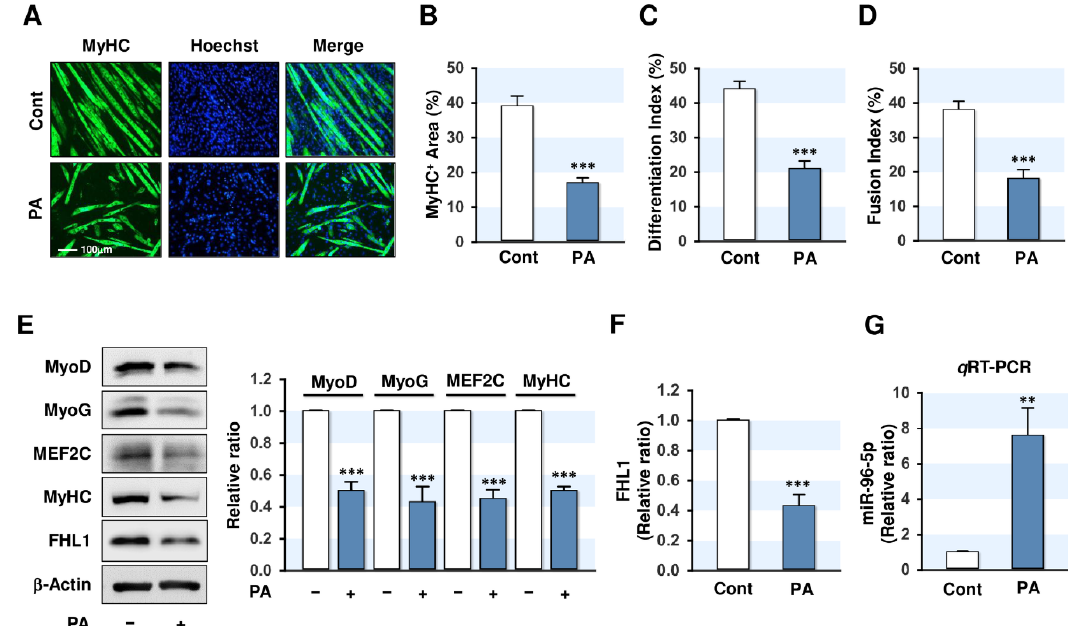
Figure 1. Palmitic acid (PA) impairs myogenic differentiation and upregulates miR ‐ 96 ‐ 5p in C2C12 myoblasts. C2C12 myoblasts were pretreated with PA (100 μ M) for 24 h and differentiated up to five days. ( A ) Immunofluorescence staining with a specific antibody against MyHC (green). Hoechst (blue) was used to stain nuclei. Scale bar: 100 μ m. ( B – D ) MyHC ‐ positive area, differentiation index, and fusion index were determined as described in Materials and Methods. ( E ) Expressions of myogenic factors and FHL1. ( F ) Quantitative analysis of FHL1 expression. ( G ) q RT ‐ PCR of miR ‐ 96 ‐ 5p (24 h after PA treatment) following normalization with U6 control. Expression levels in immunoblots were normalized with β‐ Actin. The values are expressed as the relative ratio, where the intensity of day 0 was set to one. Results are expressed as means ± SEMs ( n > 3). **, p < 0.01; ***, p < 0.001 vs. BSA control.